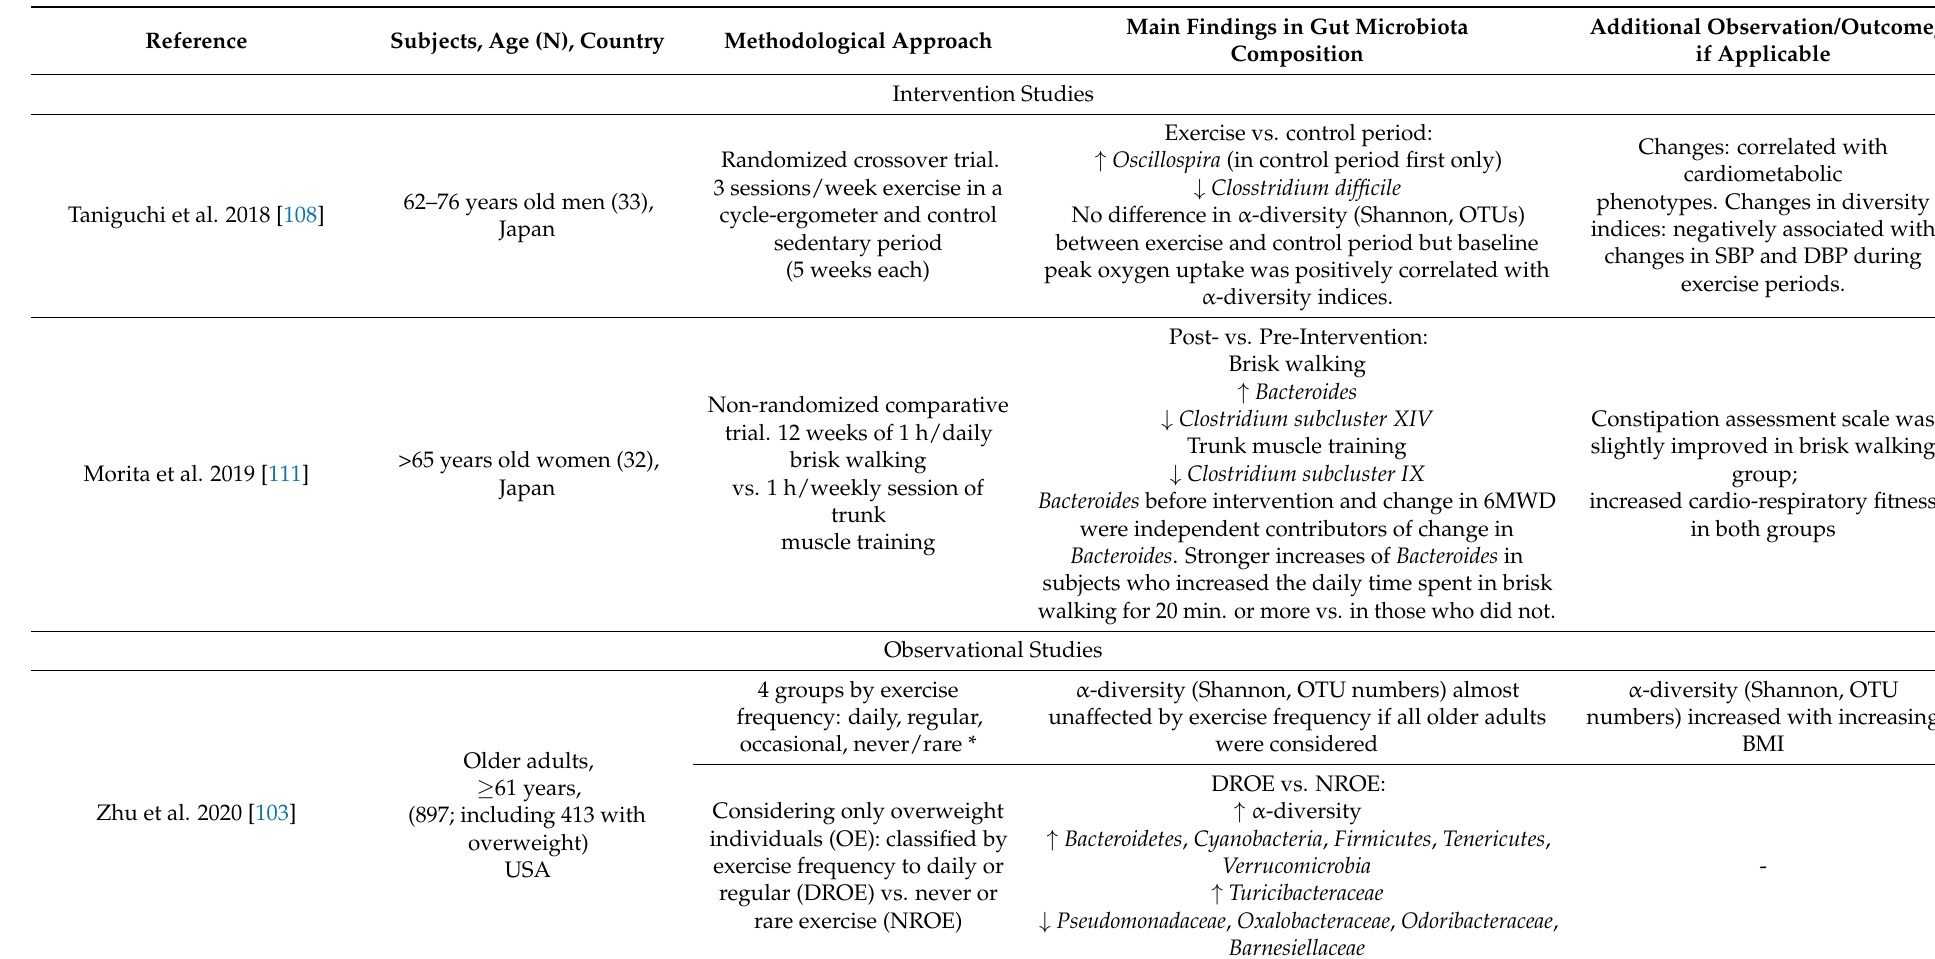
Table 1. Intervention and Observational Studies (modified, based on